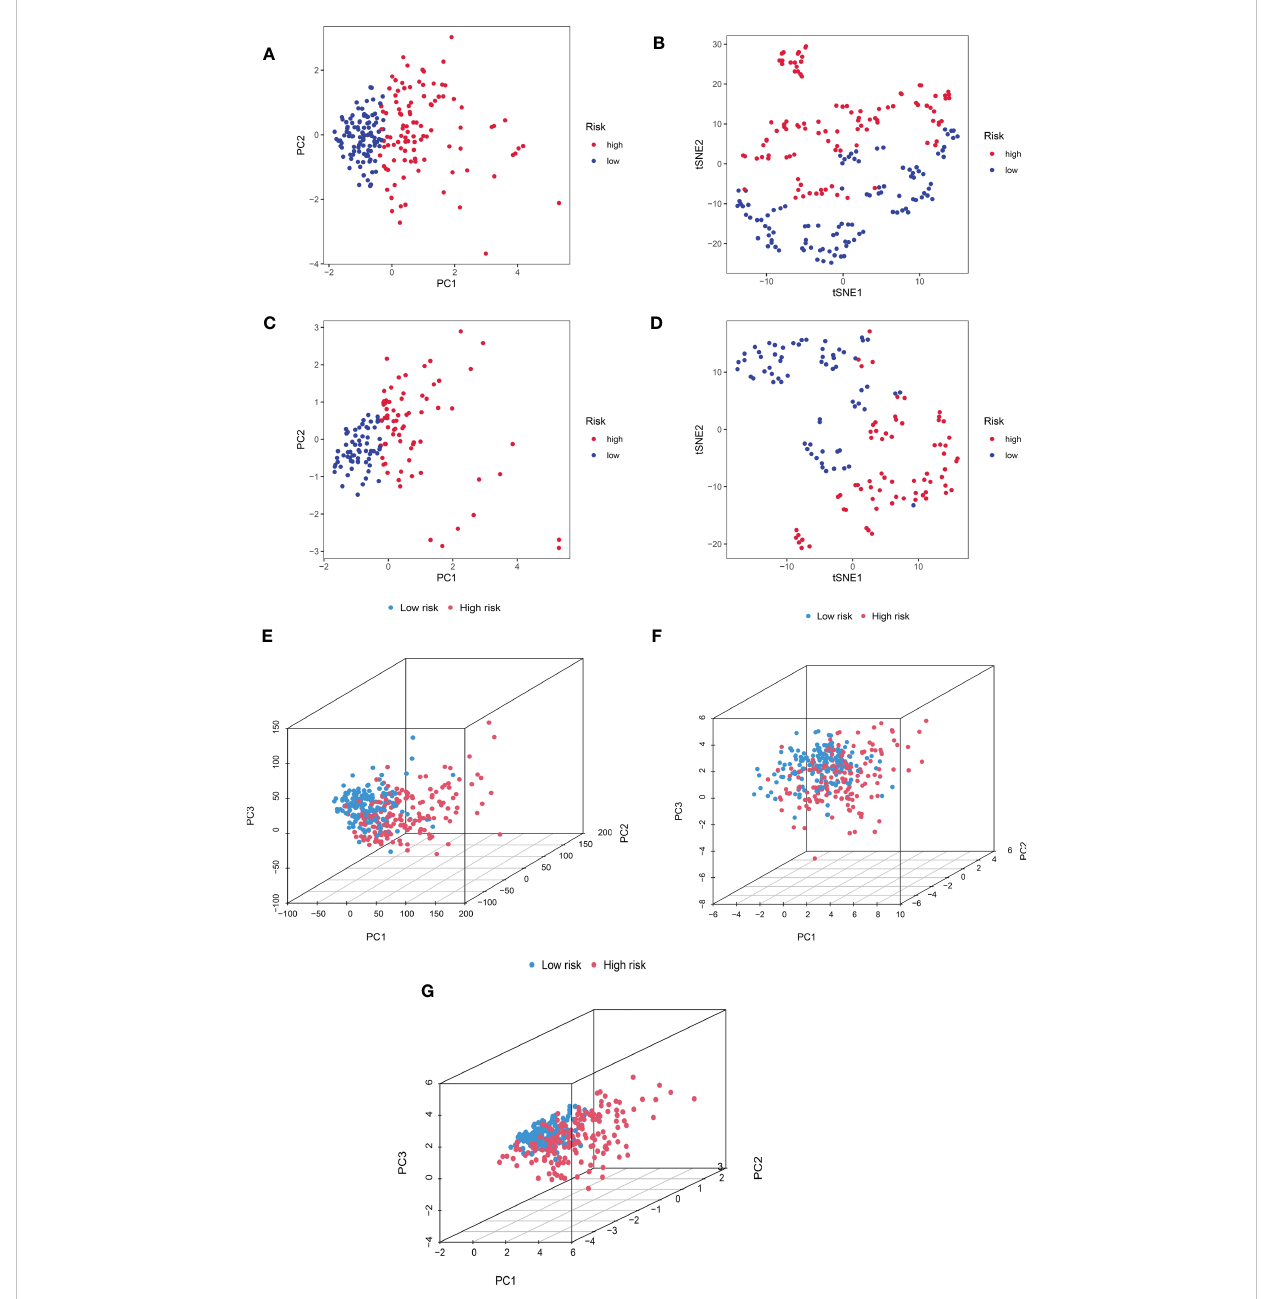
FIGURE 5 Principal component analysis. (A) PCA for the training cohort. (B) t-sne of the training cohort. (C) PCA for the test cohort. (D) t-sne of the test cohort. (E) PCA 3D map based on whole gene expression pro fi les, (F) PCA 3D map based on fever-related genes, (G) PCA 3D map based on fever- related differential expression of lncRNAs in TCGA entire